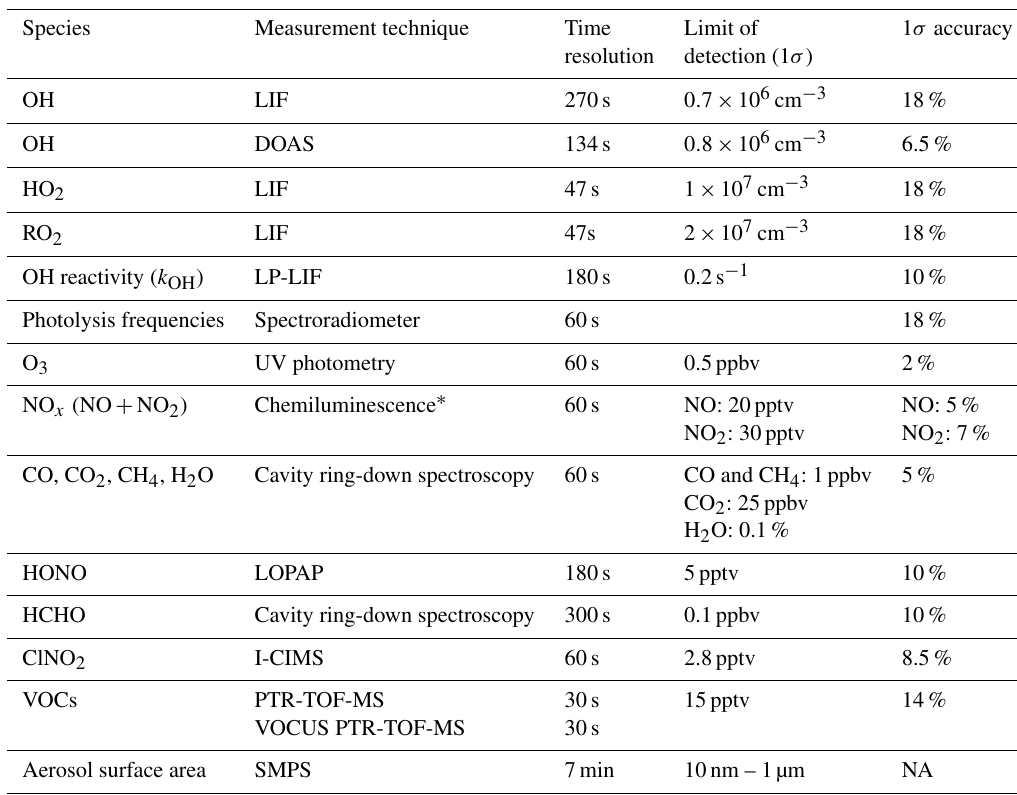
Table 2. Specification of instruments used in the JULIAC campaign for the analysis in this work.